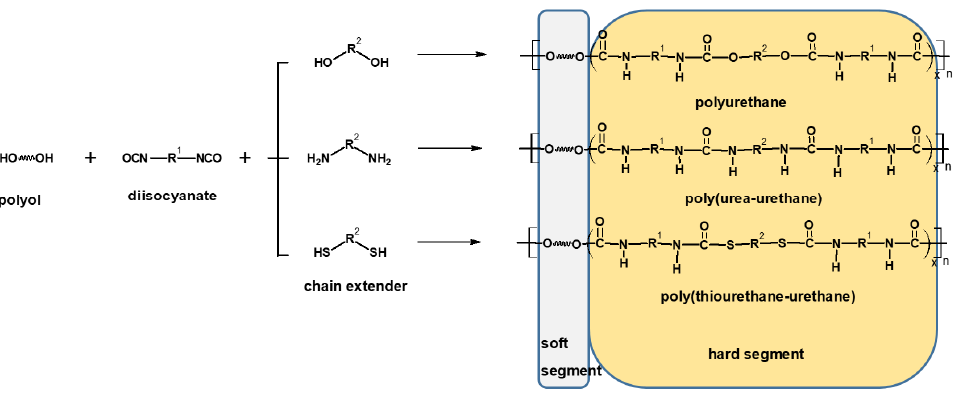
Figure 1. General scheme of reactions between polyol, diisocynate and different chain extenders.